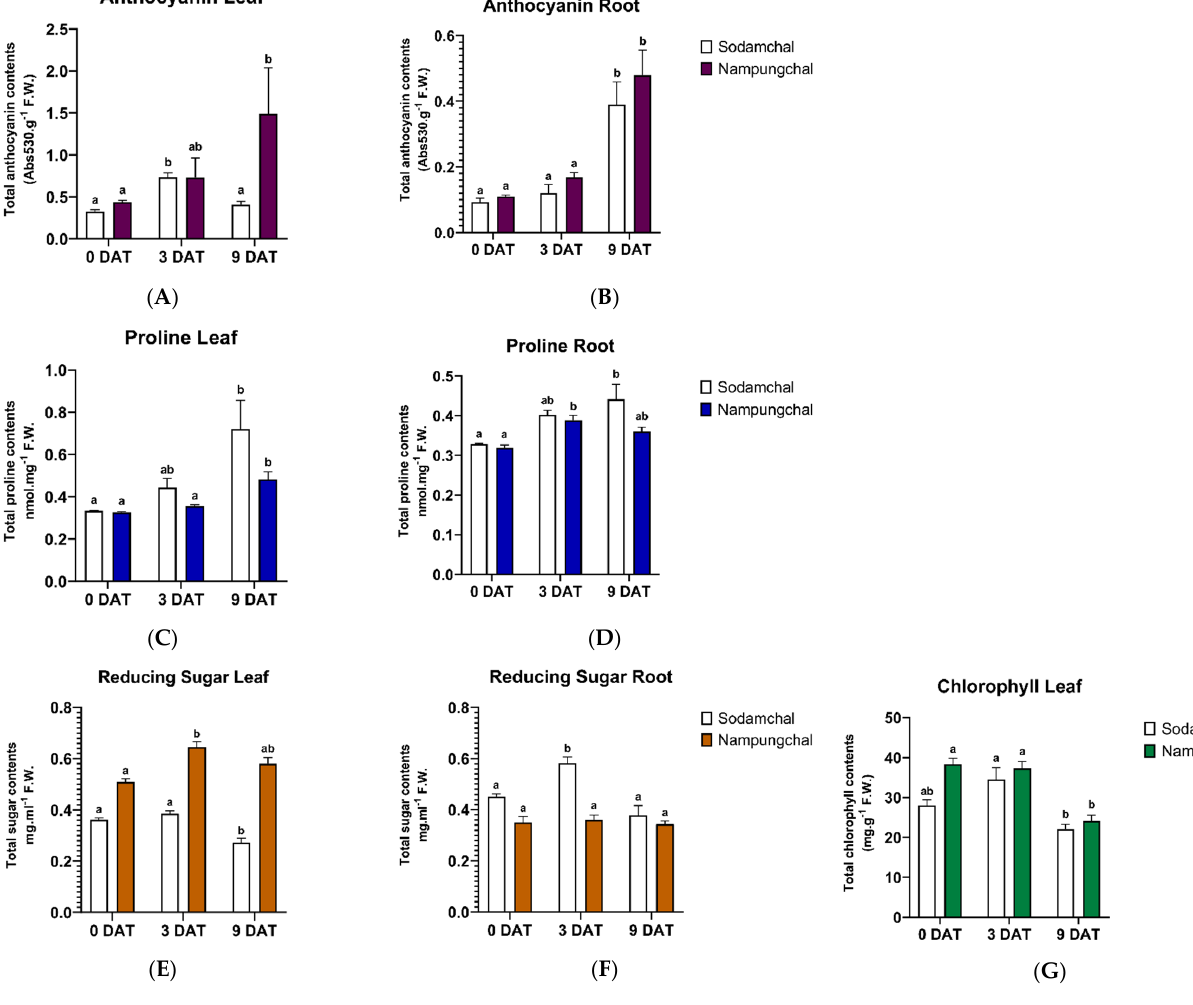
Figure 3. Quantification of physiological and biological responses of the two sorghum cultivars, Nampungchal and Sodamchal, under salt stress (DAT, days after treatment): ( A ) anthocyanin in the leaves, ( B ) anthocyanin in the roots, ( C ) proline in the leaves, ( D ) proline in the roots, ( E ) reducing sugar in the leaves, ( F ) reducing sugar in the roots, ( G ) and chlorophyll in the leaves. The y -axis represents the total contents of the physiological and biological responses, and the x -axis represents the time after NaCl treatment (days after treatment). Values represent the mean ± SEM ( n = 3). The different letters indicate significant differences among different days, using Tukey’s test at p < 0.05.